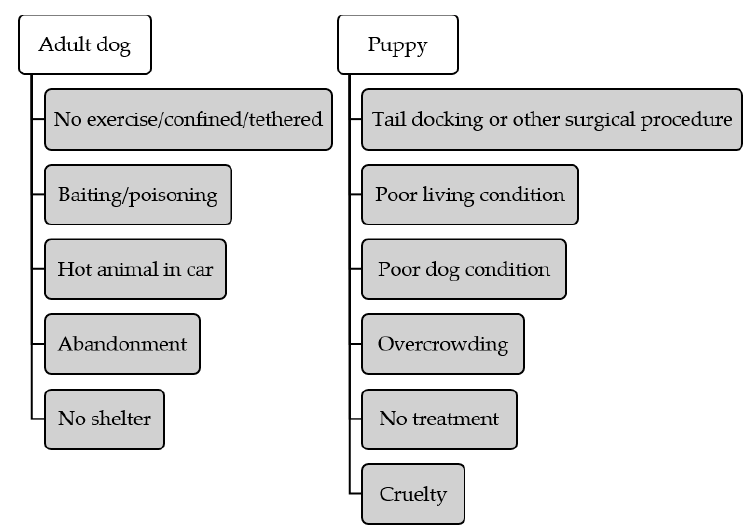
Figure 3. Positive relationships between dog age (adult dog and puppy) and complaint codes.